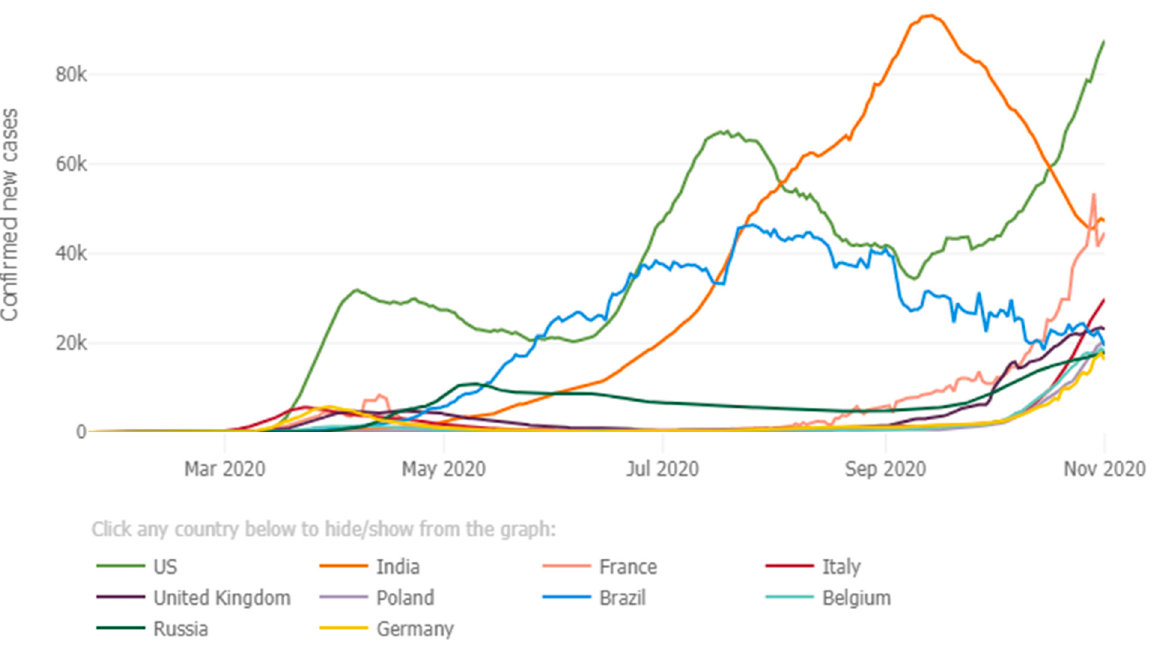
Figure 1. Daily confirmed new COVID-19 cases (5-day moving average) for the current 10 most affected countries (Source: https://coronavirus.jhu.edu/data/new-cases, accessed on 2 November 2020).